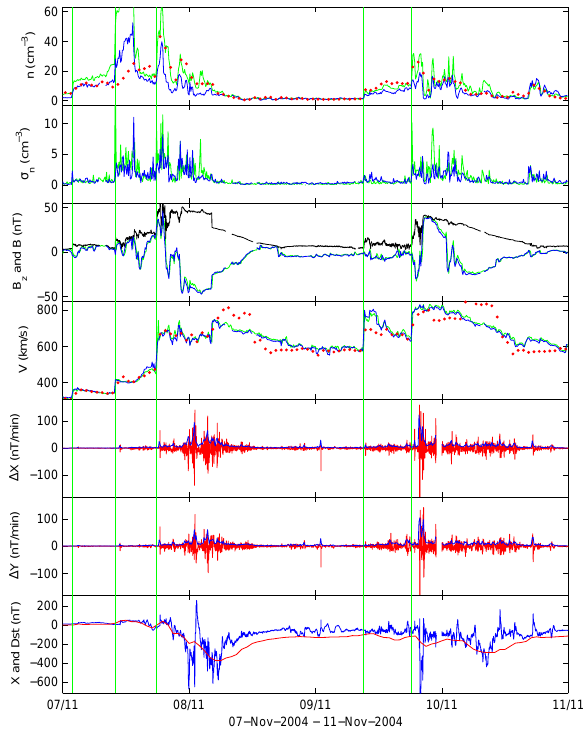
Fig. 1. The panels show, from top to bottom: solar wind density n (ACE–blue, WIND–green, SOHO–red), standard deviation σ n of the density, B z magnetic field component in GSM and total field B from ACE (black), velocity V , one-minute 1X (red) and 10-min RMS 1X (blue), one-minute 1Y and 10-min RMS 1Y , and one minute X (blue) and hourly D st (red). The period extends over the four days of 7–10 November 2004. The only available data from SOHO are the hourly average density and